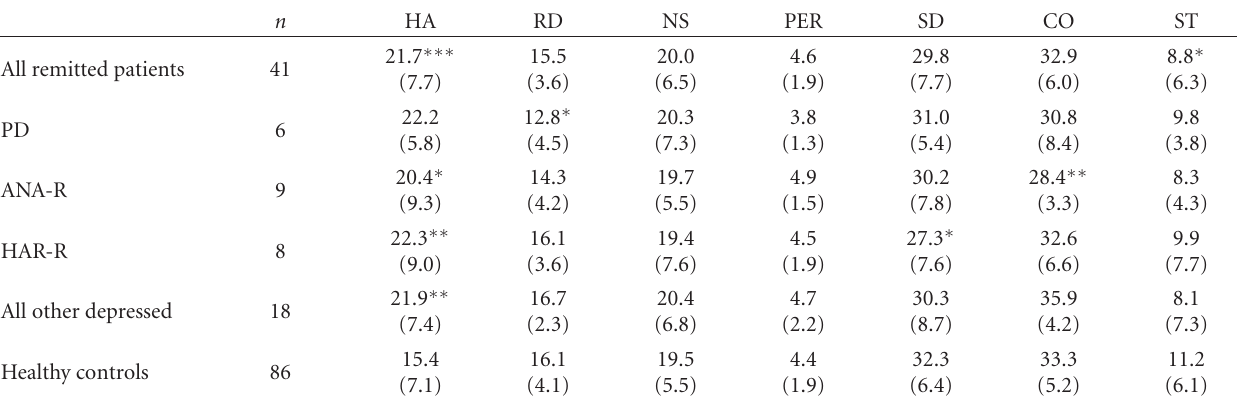
Table 2: Temperament and character (standard deviation between brackets) after full remission in psychotic depression (PD), ANA-R depression, HAR-R depression, and all other depressed patients, as well as in healthy controls ( ∗∗∗ P < 0 . 001; ∗∗ P < 0 . 0071; ∗ P < 0 . 05: compared with